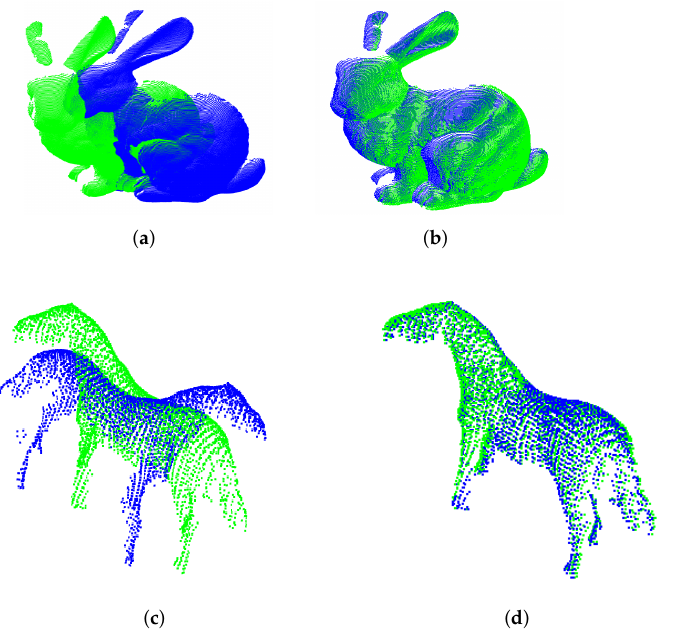
Figure 5. Alignment of the Bunny and Horse models, respectively, for CP-ICP and the proposed method. ( a ) CP-ICP (Bunny model). ( b ) UPS (Bunny model). ( c ) CP-ICP (Horse model). ( d ) UPS (Horse